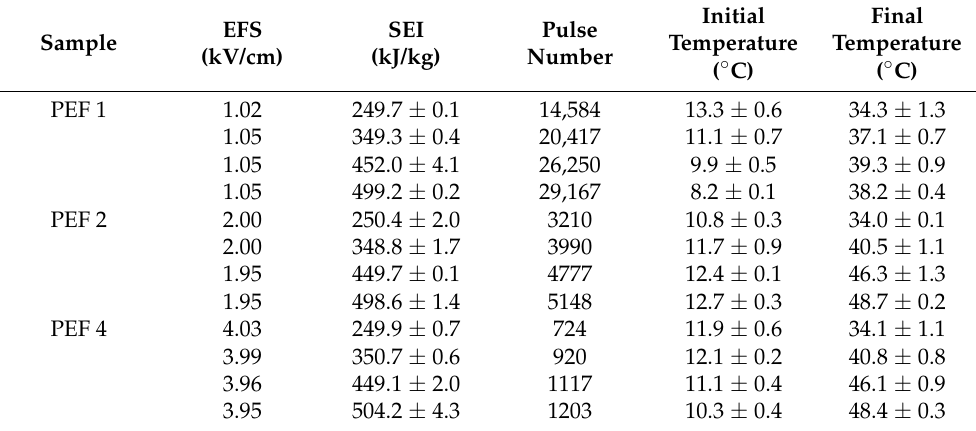
Table 1. Summary of processing parameters and temperature of cassava flour suspension observed during PEF